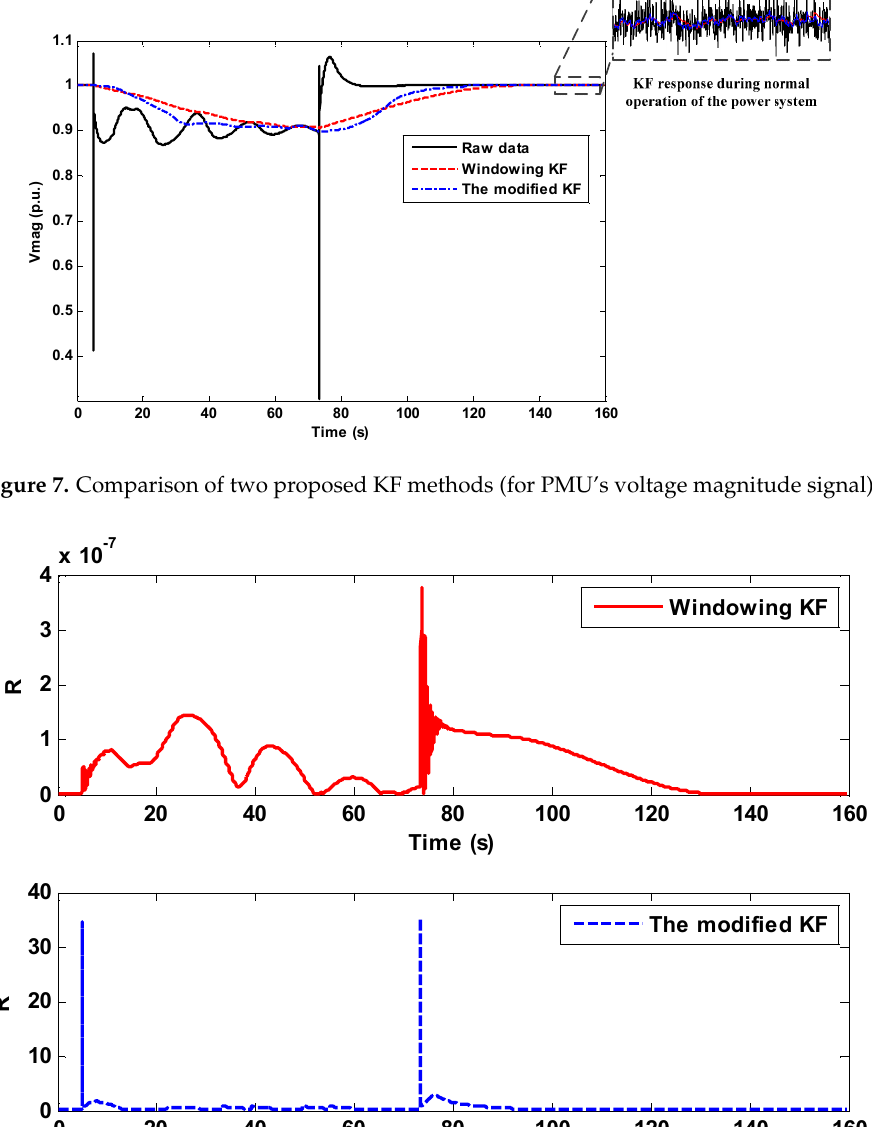
Noise Figure 6. Difference between voltage responses from simulation and an actual PMU for the same disturbance. 6.2. Kalman Filter Performance Comparison of Two Proposed Methods The developed KF methods are applied on HIL PMU data. A power system is disturbed with